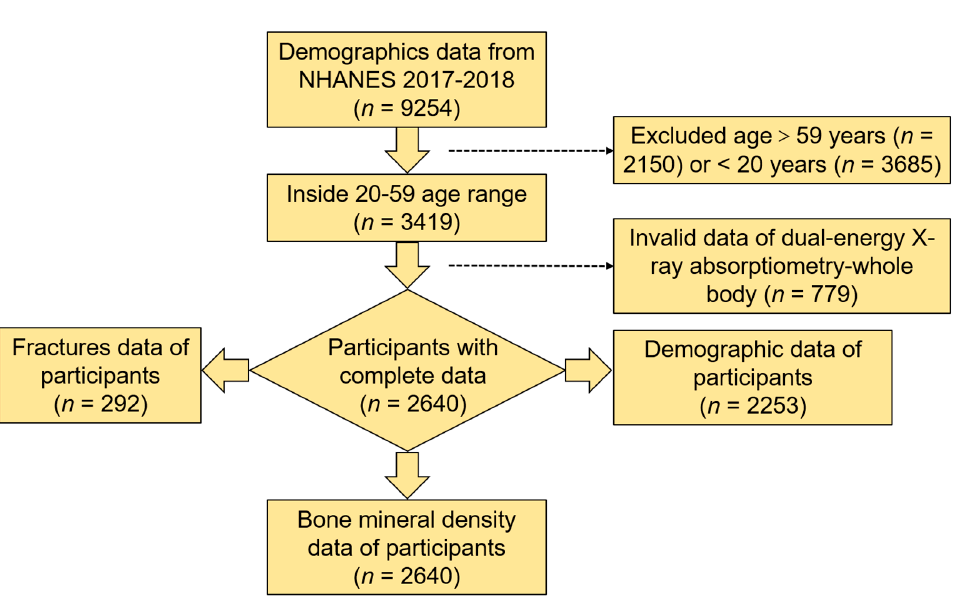
Figure 1. Flow chart of the selection process from the 2017–2018 NHANES. Using total BMD as a selection criterion, 2253 individuals (1073 (47.63%) men and 1180 (52.33%) women) with osteopenia were selected; the data analysis is given in Table 1. Americans who were female ( p < 0.001), over 65 years old ( p < 0.001), had a lower BMI ( p < 0.001), were educated to high school graduation or equivalent or to less than 9 th grade ( p = 0.049), or who had been born abroad ( p = 0.008) were more likely to have an increased risk of osteopenia. A recent study [25] demonstrated that fracture incidence varies with socioeconomic status, race, and ethnicity, but race, ethnicity ( p = 0.801), family income ( p = 0.175), and current smoking status ( p = 0.089) have no significant effect on BMD in the